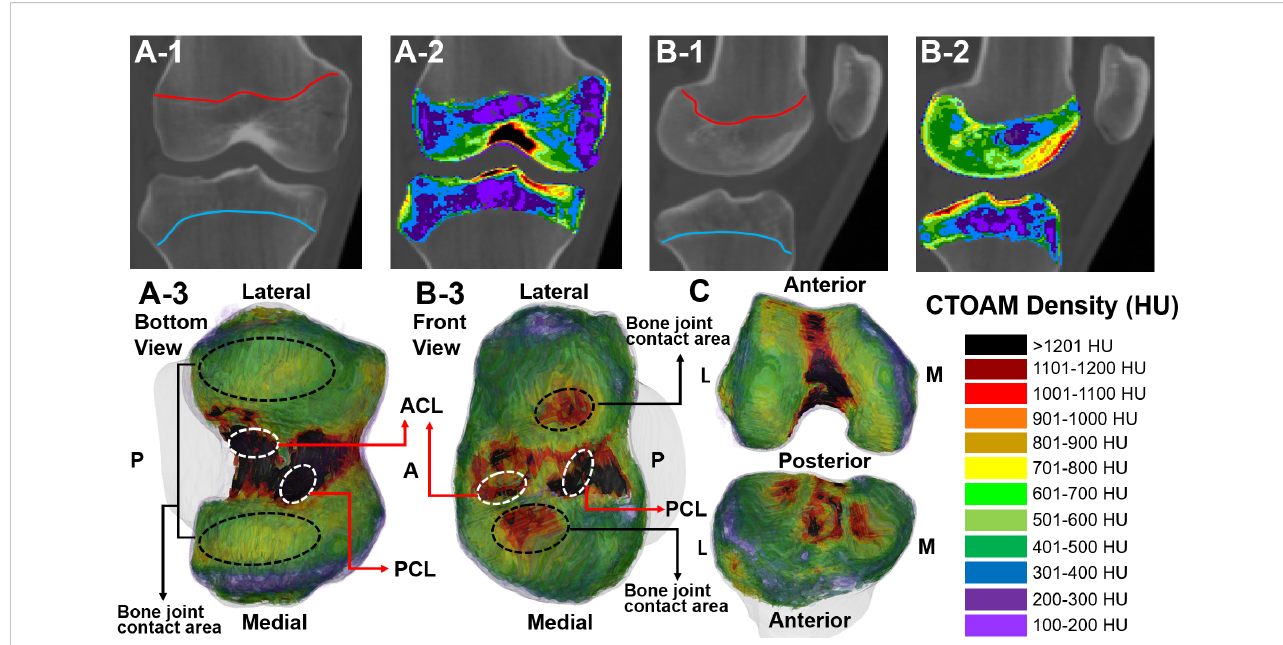
FIGURE 1 Range and post-processing reconstructed model of subchondral bone image segmentation (CT value, Houns fi eld Unit, HU) of the knee joint in two subjects. (A-1, B-1) CT segmentation range of the knee the epiphyseal line; (A-2, B-2) CTOAM segmentation images of the knee epiphyseal line; (A-3, B-3) CTOAM model of the reconstructed bone tissue of the knee joint; (C) Reconstructed knee joint model after opening (front view); CTOAM image density interval. These pictures were from the judo athletes. ACL is anterior cruciate ligament; PCL is posterior cruciate ligament; M is medial; L is